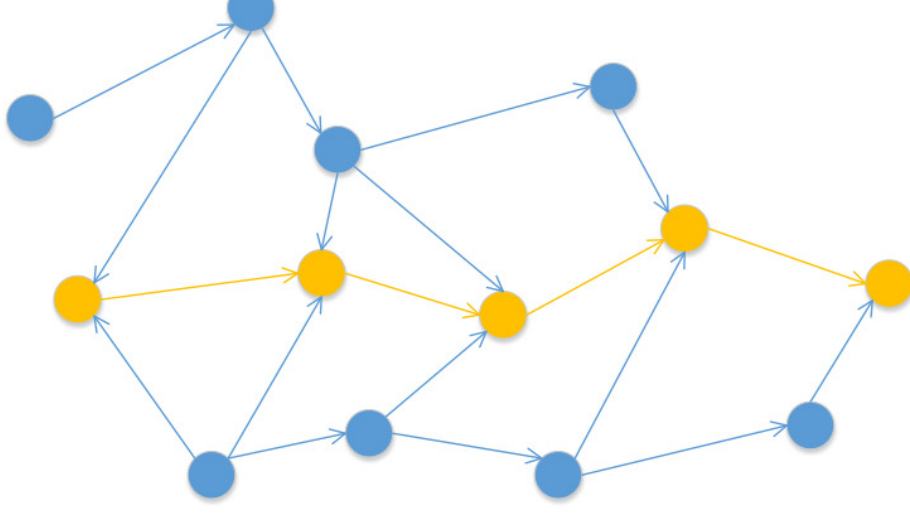
Figure 3. Geographic routing